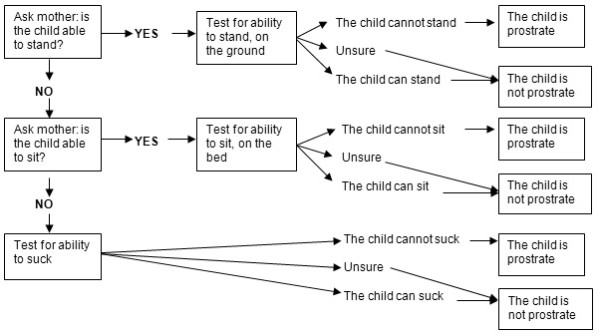
Algorithm for evaluation of prostration.